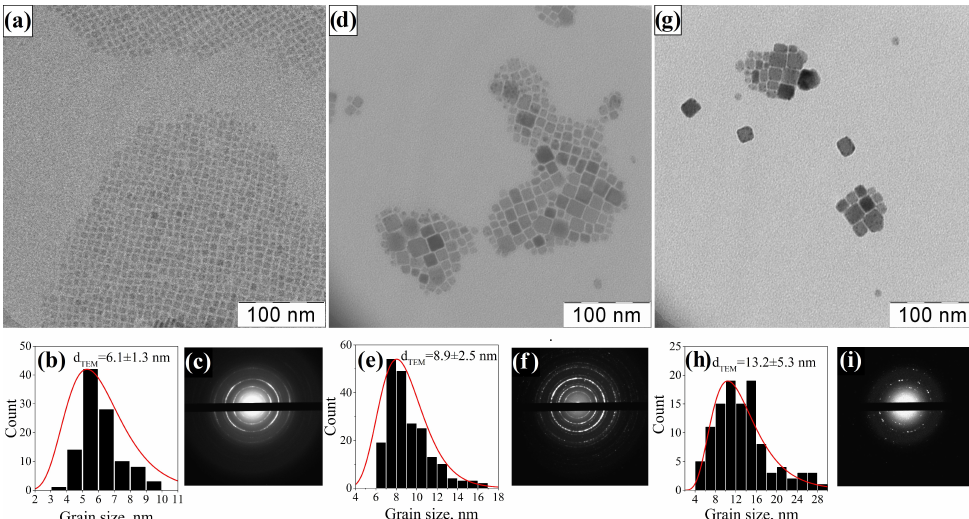
Figure 4. TEM images, size distribution diagrams and electron diffraction patterns of CsPb(Br/Cl) 3 ( a – c ); CsPbBr 3 ( d – f ); and CsPb(I/Br) 3 ( g – i ).